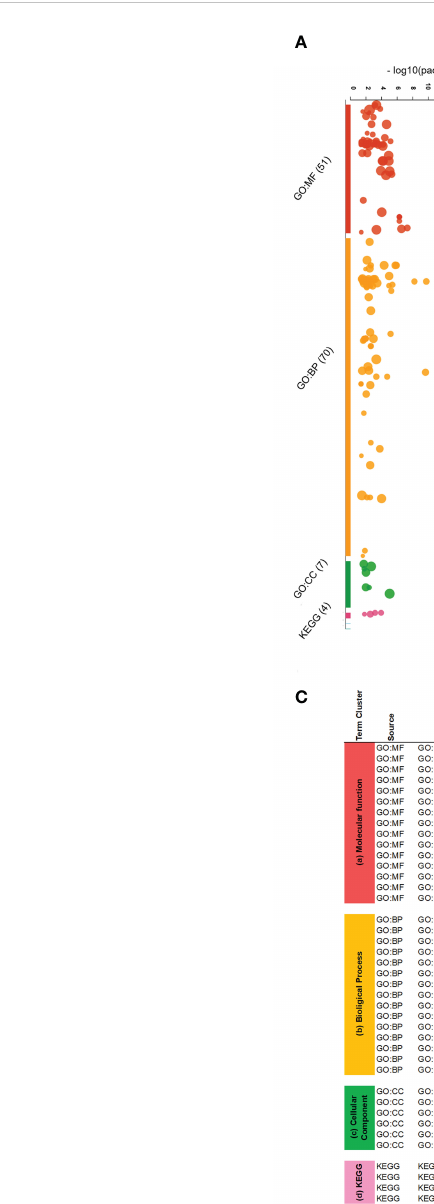
HCT , GPAT5 . In this context, the main nod for the interaction network was mapped for phenylpropanoid biosynthesis which was closely associated with either lignin metabolic process or suberin biosynthesis (Figure 2B; Supplementary Table 5).